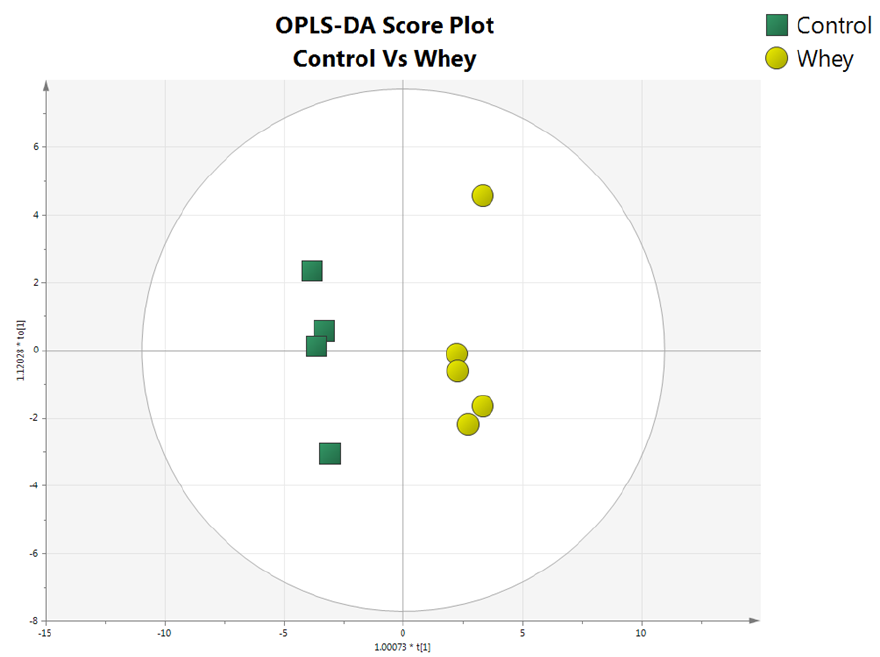
Figure 2. The Orthogonal Partial Least Squared Discriminant Analysis (OPLS-DA) score plot of plasma samples of whey protein fed rats against controls.